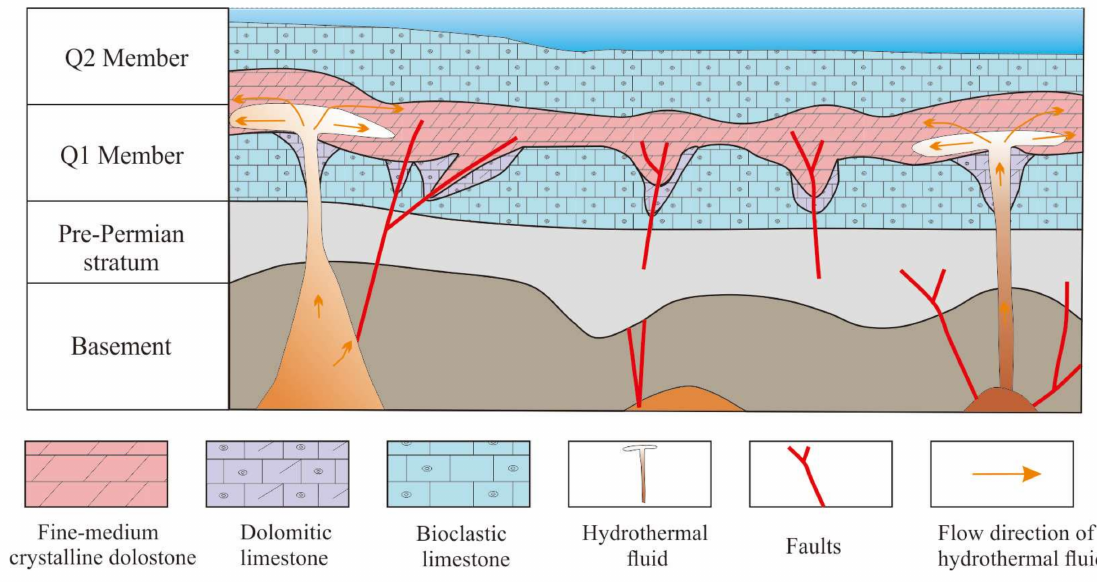
Figure 9. Genetic model of dolostone formation affected by the first stage of hydrothermal